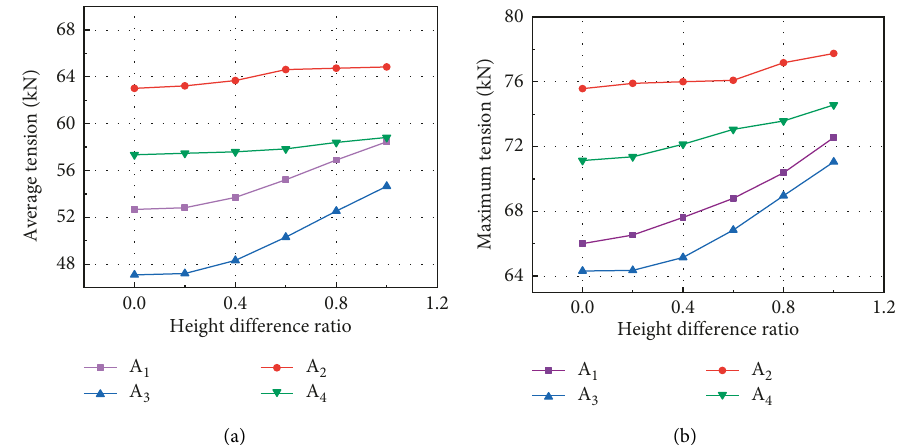
Figure 13: Relationship between height difference ratio and conductor hanging point tension: (a) Average tension, (b) Maximum